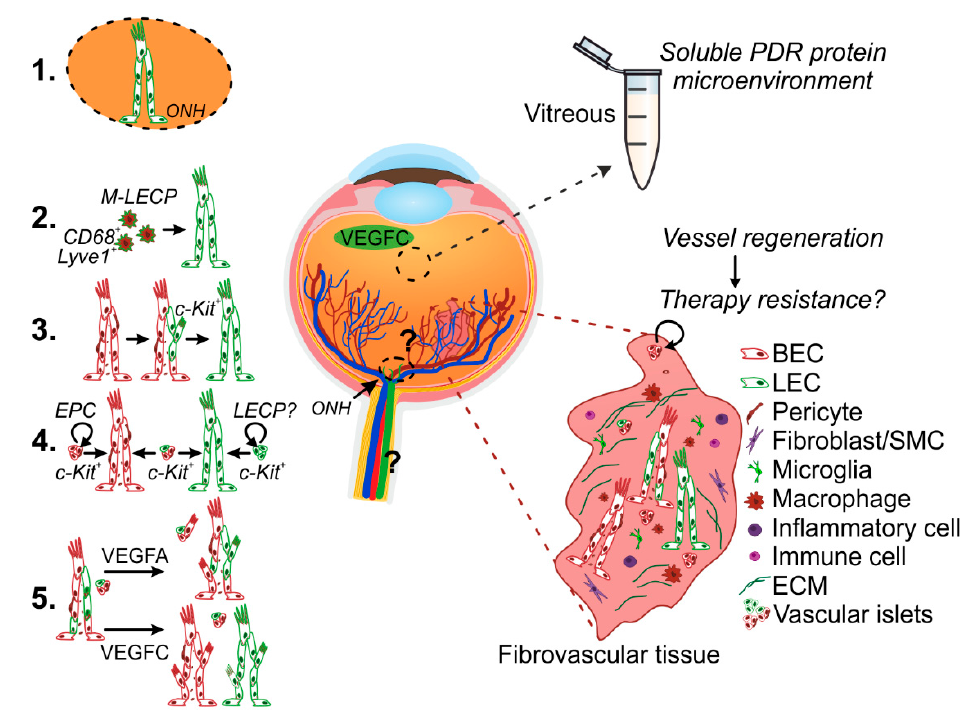
Figure 2. Potential mechanisms of pathological lymphatic vascular formation in PDR. Lymphatic vessel formation was recently discovered in the ischemia- and inflammation-induced neovascularization occurring in PDR [2,45]. The vitreous fluid collected during vitrectomy reproduces the soluble microenvironment of growth factors, cytokines, and metabolites within the posterior eye chamber and is utilized to indirectly investigate the ongoing pathological processes in the diabetic retina. The patient-derived fibrovascular tissue, excised during vitreoretinal surgery, provides invaluable material for understanding PDR pathophysiology in the complexity of the live human tissue microenvironment. The complex ischemic and inflammatory PDR microenvironment, including VEGFC detected in vitreous, can drive PDR lymphatic vascular formation. Lymphatic vascular formation is essentially achieved through pathological lymphangiogenesis from pre-existing lymphatic vessels and/or de novo, lymph-vasculogenesis. The question on whether the human optic nerve and retinal regions include yet uncovered lymphatic vasculature remains to be investigated (1). Macrophages which have the ability to transform into LECs (M-LECPs) can contribute to de novo lymphatic vascular formation (2). Alternatively, lymphatic neovascularization could occur through trans-differentiation from blood endothelial cells (BECs) (3) or through LEC fate induction in resident or incoming EPCs (4). Sphere-like vascular cell structures interspersed within the PDR fibrovascular tissues could be the vessel primordia for neo (lymph) vascularization. This could also provide a mechanism for vessel regeneration and thus be responsible of re-vascularization after treatment (therapy resistance). The abnormal PDR neovasculature displays heterogeneous population of abnormally differentiated vessels [45]. Ex vivo culture led to heterogeneous vessels and islet sprouting in presence of VEGFA, while VEGFC promoted segregation of the heterogeneous vasculature into separate vessels (5) [45]. More in-depth studies are needed in order to understand the signals and mechanisms involved in the pathological neovascularization observed in PDR. ONH, optic nerve head; BEC, blood endothelial cell; LEC, lymphatic endothelial cell; SMC, smooth muscle cell; LEC-P, LEC-precursor; M-LECP, macrophage-derived